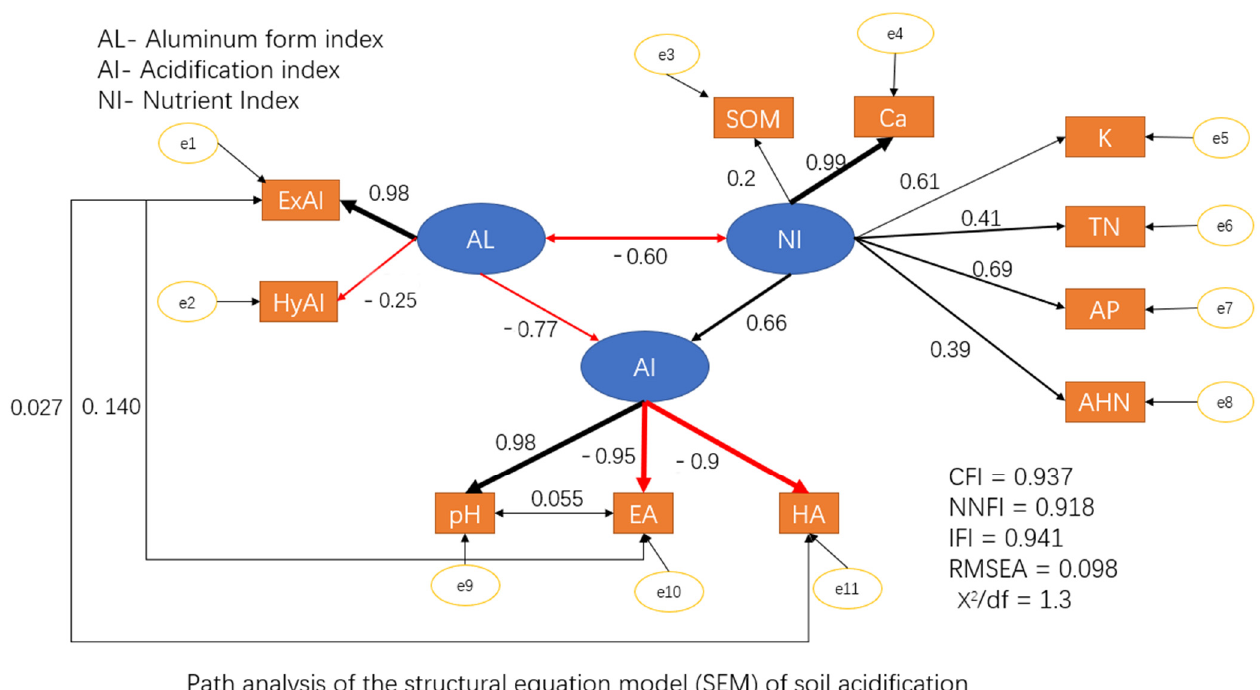
Figure 6. Correlation analysis of the soil parameters by the structural equation model. The thick solid lines indicate the significant correlation path ( p < 0.01), and the thin lines indicate the nonsignificant correlation path. The number next to each line is the standardized path coefficient, and the width of an arrow indicates the strength of the relationship.